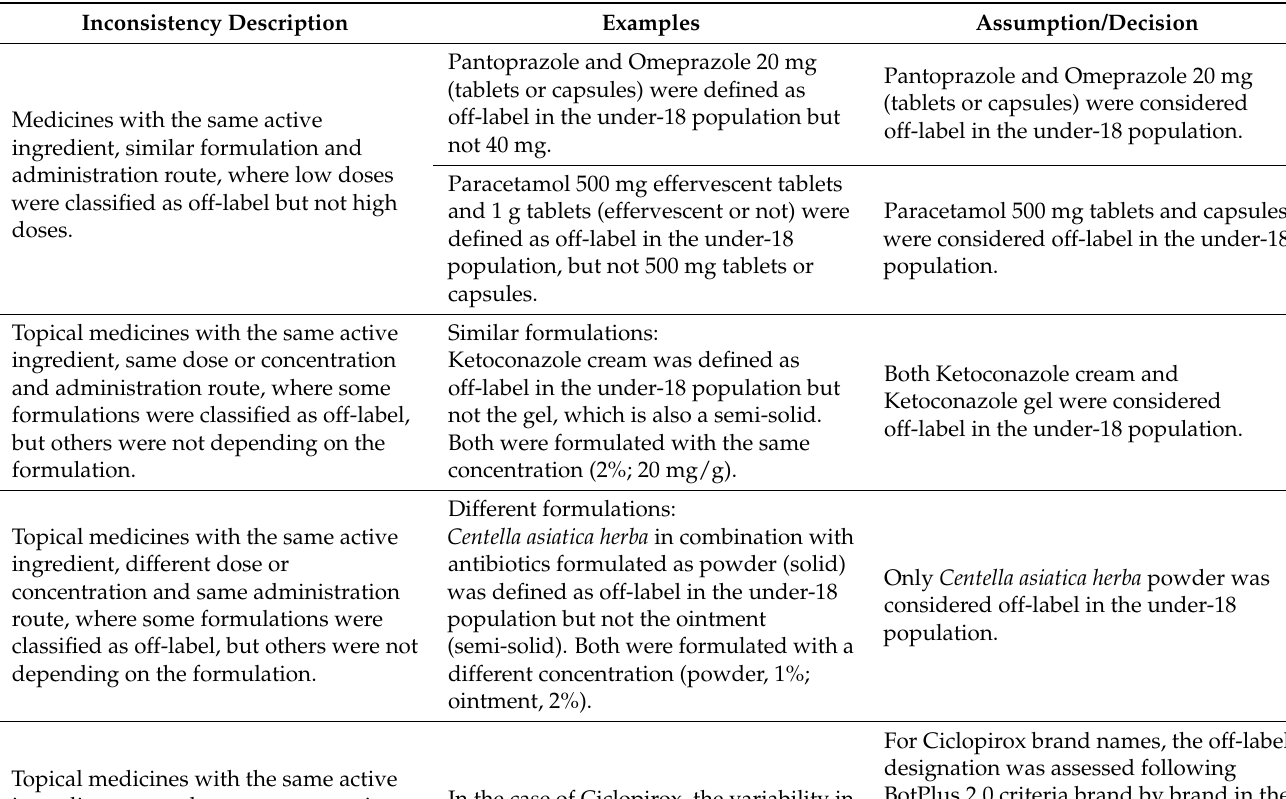
Table 1. Definition of inconsistencies that were identified in the BotPlus 2.0 database according to off-label indication in the under-18